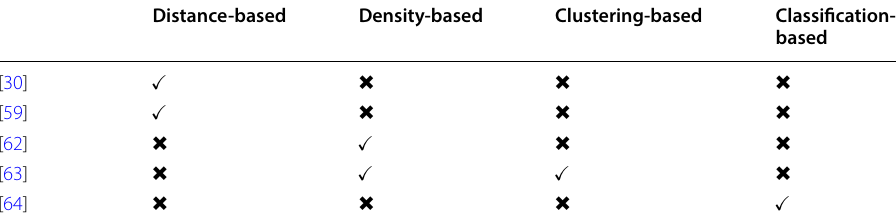
Table 2 Summary of statistical methods and author’s